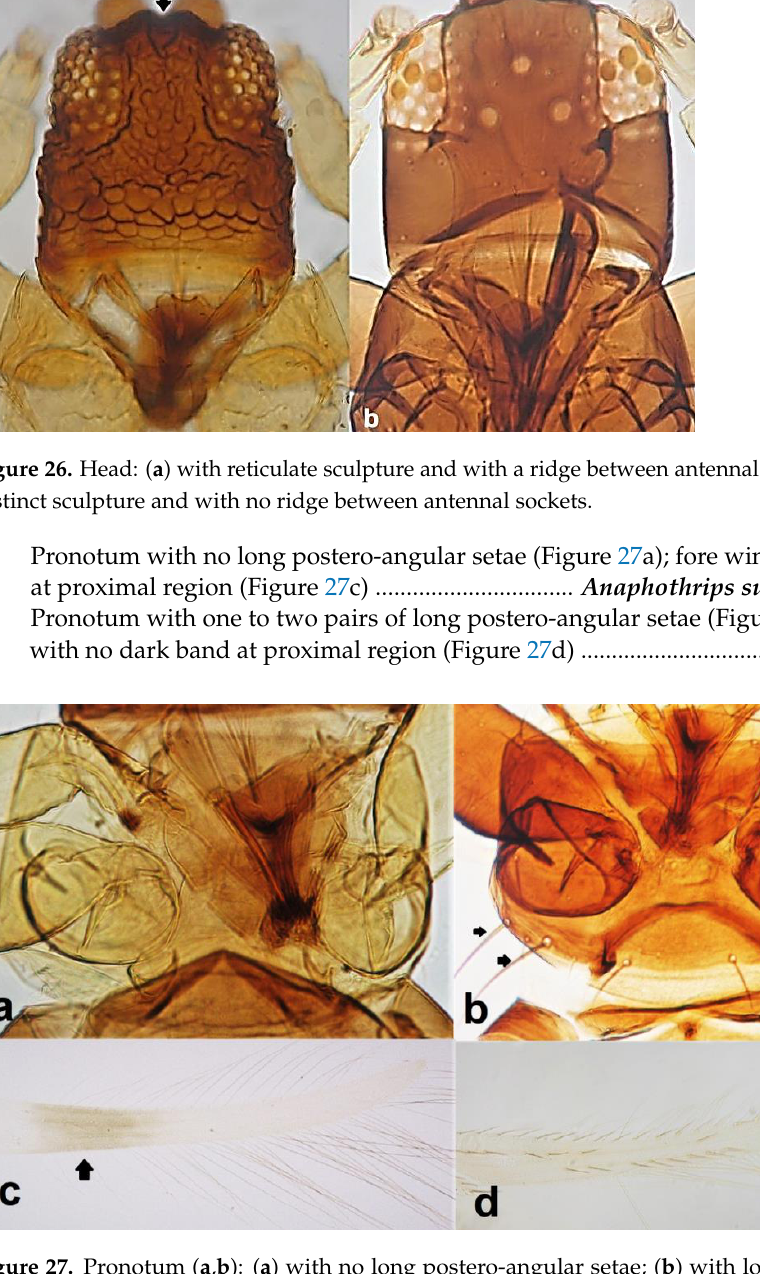
Figure 27 . Pronotum ( a , b ): ( a ) with no long postero-angular setae; ( b ) with long postero-angular setae present; fore wing ( c , d ): ( c ) with a dark band at proximal region; ( d ) with no dark band at proximal region.